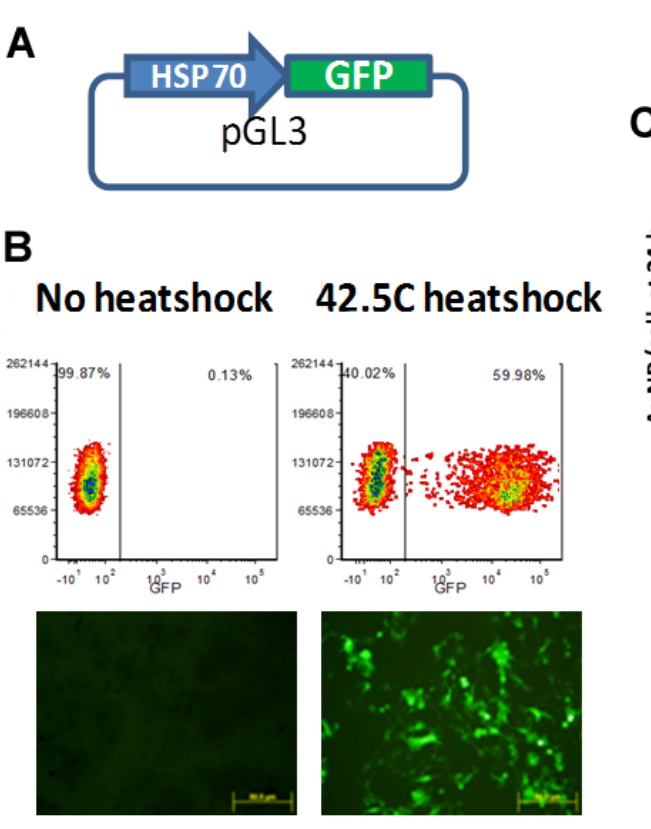
Figure 2. Transfection of HeLa cells with the HSP70- Enhanced Green Fluorescent Protein (EGFP) expression vector and quantitative measurement of AuNR uptake in vitro . ( A ) Cartoon of the expression vector; ( B , C ) HeLa cells were transfected with the vector using lipofectamine LTX reagent, and 24 h later the cells were either left at 37 °C or heat-shocked at 42.5 °C for 30 min. The following day, cells were analyzed for EGFP expression via flow cytometric analysis or fluorescence microscopy ( B ); B16-luc cells were plated in 96-well plates and AuNR were added at increasing concentrations. After 24 h, the cells were washed and lysed. The number of AuNR in each well was determined using UV/VIS spectroscopy ( C ); A standard curve was generated by adding known numbers of AuNR to wells, and a graph showing the number of particles present in the cells at 24 h vs. the number added at 0 h is